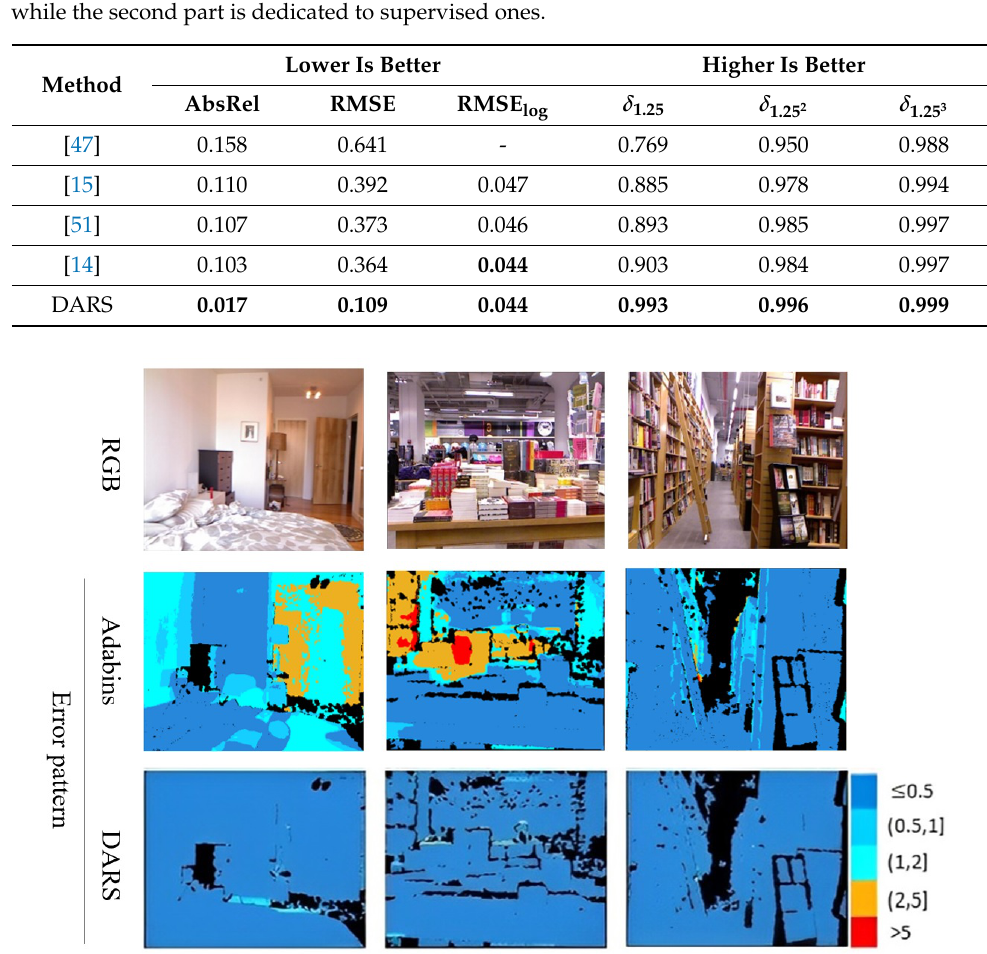
Figure 10. Visual results related to comparative study on NYUv2 dataset. The results of Adabins [14], as the second best method, are brought. Also, numbers on the right side of error patterns are in